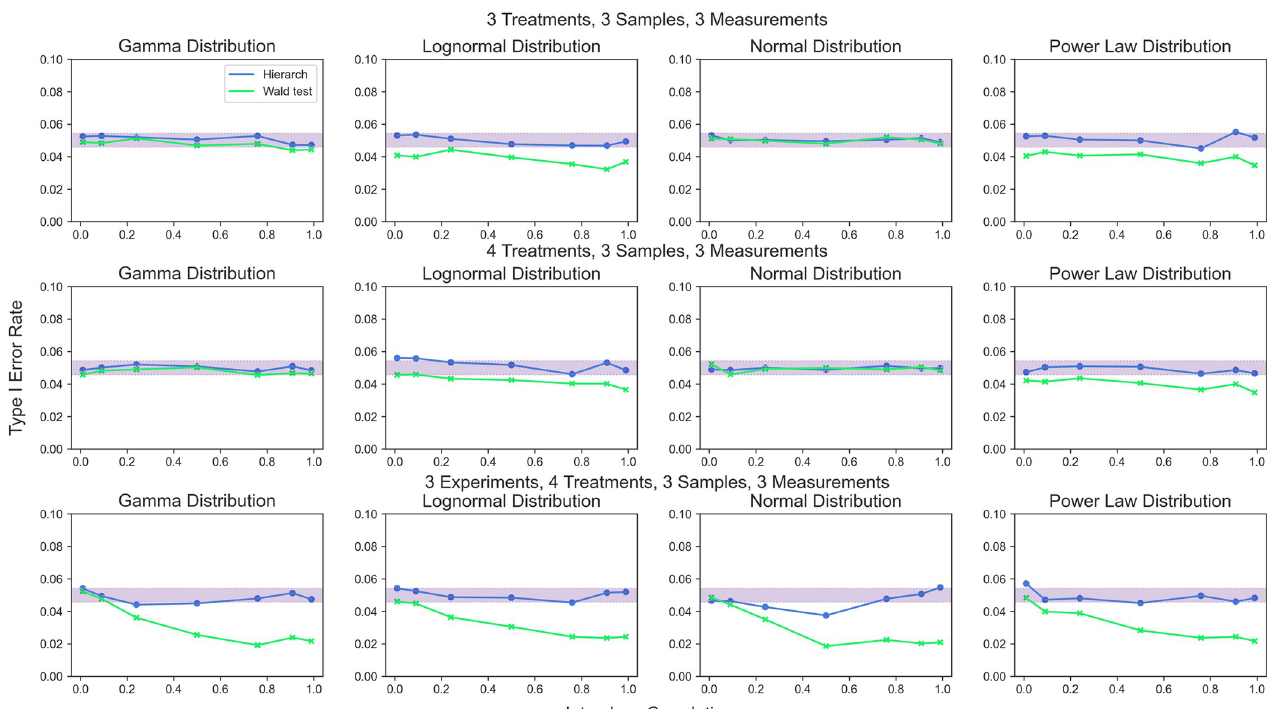
Fig 11. Type I error rate for hierarchical randomization test and the Wald test. Shaded area represents the 95% binomial confidence interval around a 5% type I error rate.